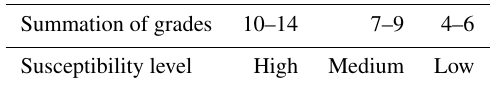
Table 2. Susceptibility level of landslide (modified from Lin,